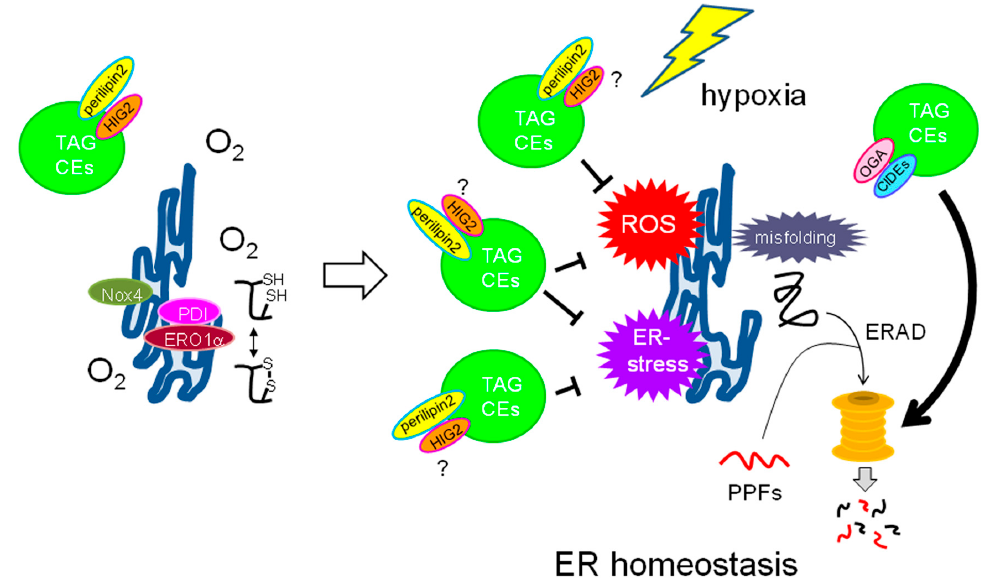
Figure 3. Potential effect of LDs on the ER-stress condition in cancer cells caused by O 2 deficiency. Cancer cells sufficiently supplied with O 2 show proper protein folding processes in the ER, including disulfide bond formation in association with multiple enzymatic activities as depicted. However, these processes may be dysregulated under hypoxia, thereby leading to redox imbalance. Accumulated misfolded proteins result in the ER-stress condition with generation of ROS. LDs are expected to suppress this toxic condition. Perilipin2 contributes to the maintenance of ER